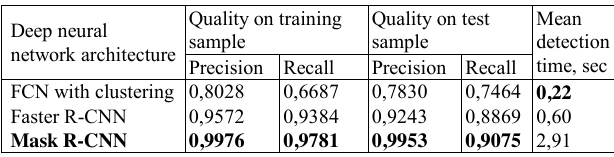
Figure 4. Human head detector based on Faster R-CNN